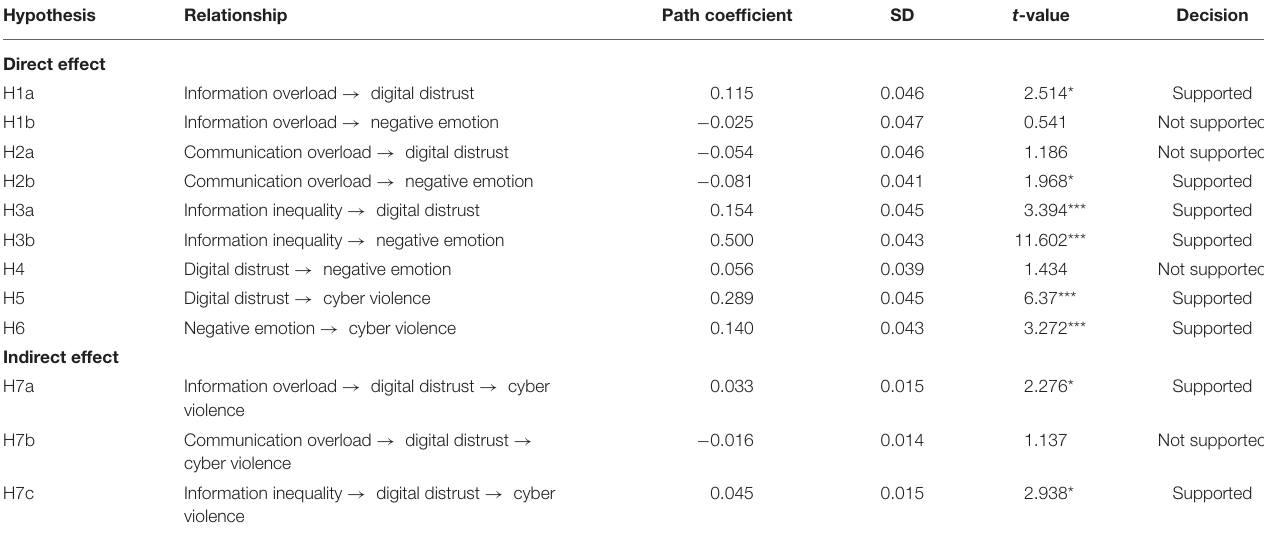
TABLE 5 | Path coefficients and hypothesis testing.